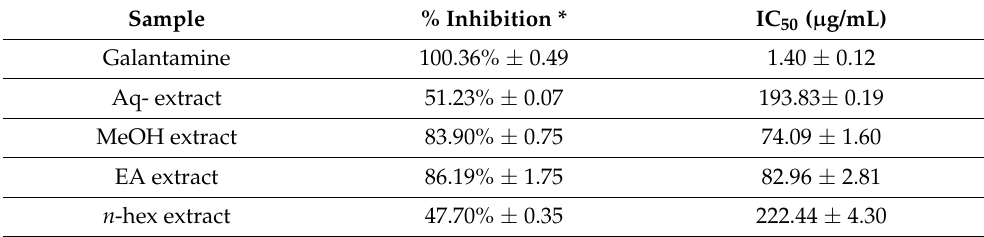
Table 1. The inhibitory activity of C. grandis extracts against acetylcholinesterase enzyme.